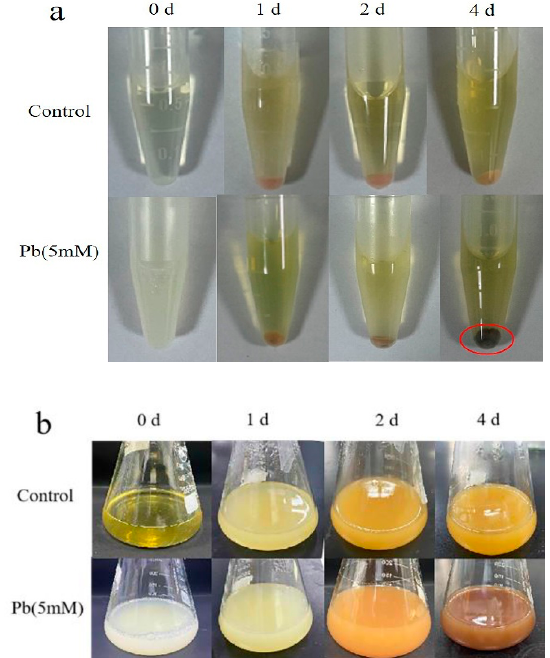
Figure 1. ( a ) The cells of PQ7 turn black in the presence of lead nitrate (5 mM). The red circle highlights the black precipitates. ( b ) The color change of PQ7 broth with or without lead nitrate (5 mM). The cells were cultivated at 30 °C with 200 rpm shaking speed. At the 4th day, the broth was brown with black precipitate after centrifugation.